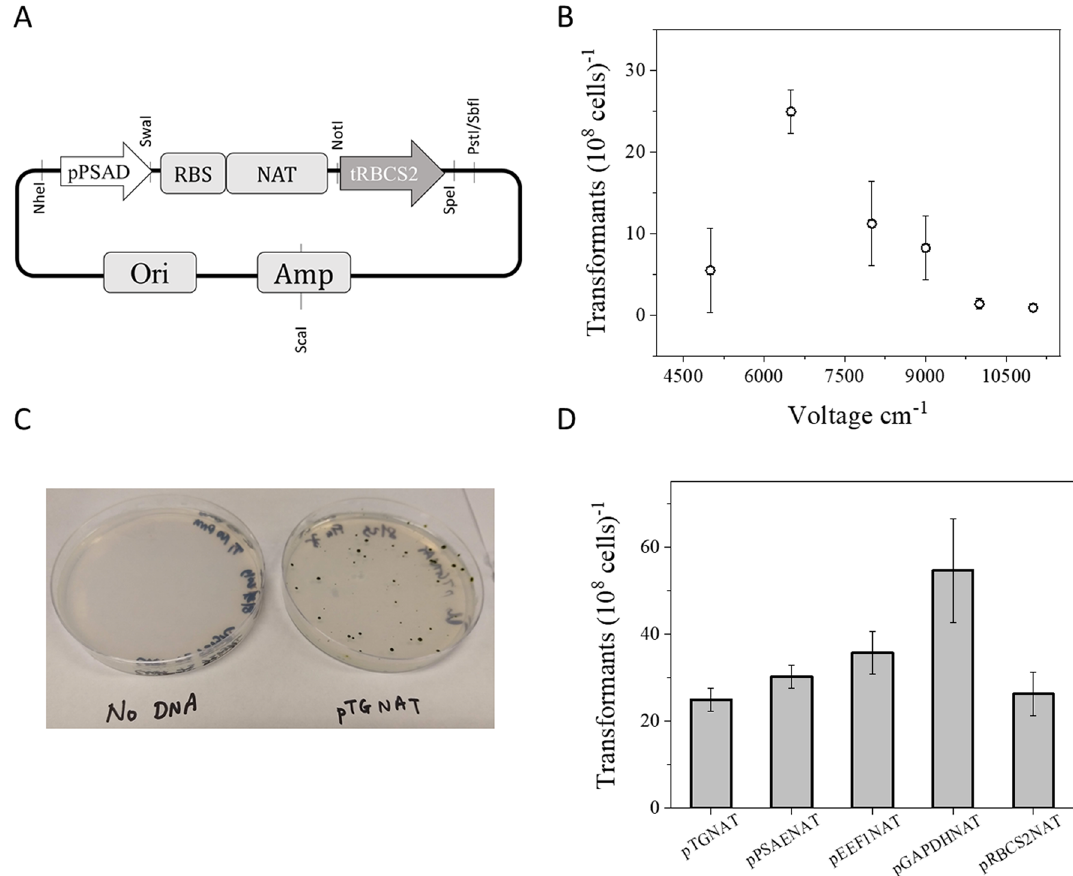
Figure 3. Optimization of electroporation methods: ( A ) Biobrick-style clonNAT resistance plasmid used for initial studies. Restriction sites are shown. RBS: ribosome binding site; Ori: Origin of replication; Amp: Ampicillin resistance marker, ( B ) Relative transformation efficiency under different field strengths (5000, 6500, 8000, 9000, 10,000, 11,000 Vcm −1 ), ( C ) clonNAT resistant colonies on selective agar plates with optimized parameters using Sca I linearized pTGNAT plasmid, ( D ) relative transformation efficiency of constructs expressing clonNAT resistance gene driven by various endogenous Picochlorum celeri promoters. Data represents the average and standard deviation for 3 technical